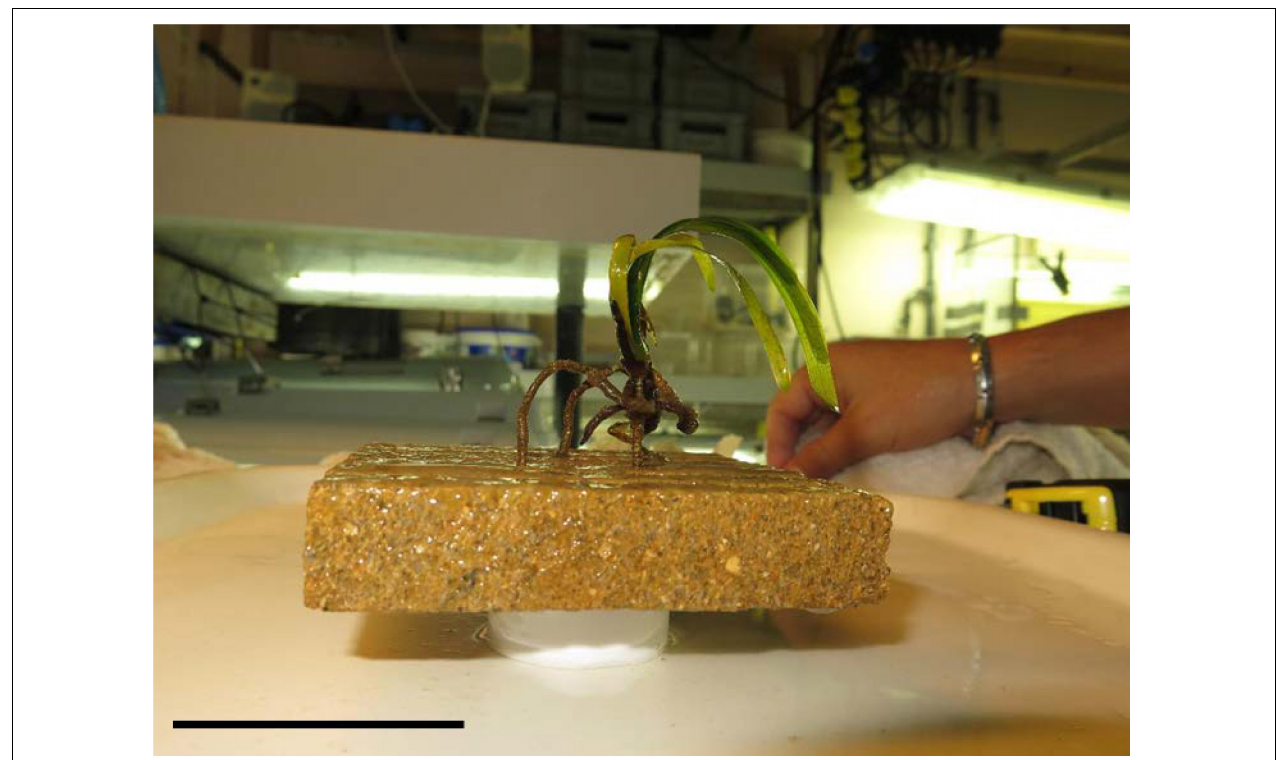
FIGURE 5 | Detail of a “seedling on stilts.” Over time, the seedling adventitious roots grew longer, rising the seedling up to several centimeters above the tile surface without causing a significant adhesion. The tip of the roots leans on the plate or attaches to the substrate only with the distal portion. Scale bar, 5 cm.